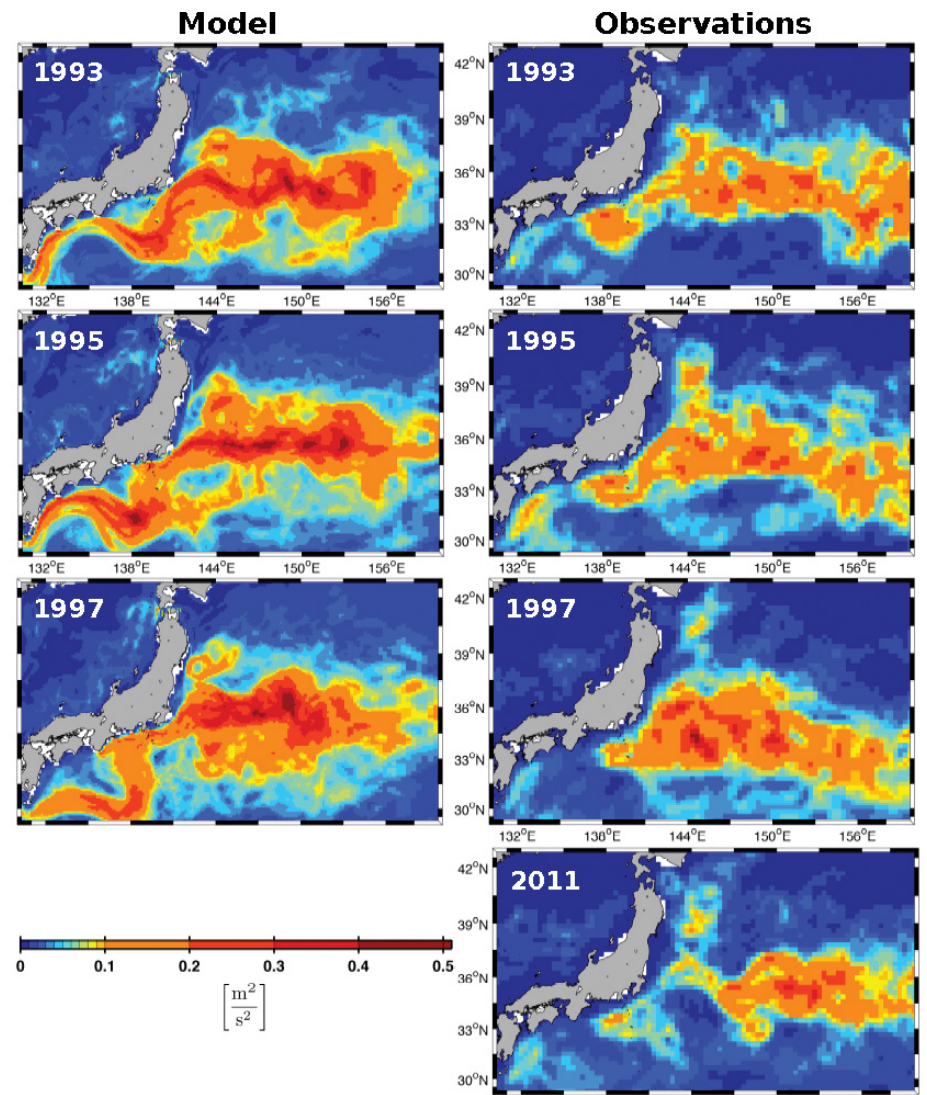
Fig. 4. Eddy kinetic energy as defined by Eq. (1). The left row of panels refers to simulated nominal years indicated in the respective upper left corners. The right row refers to estimates based on geostrophic velocity anomalies as observed from space. Due to lagged data access, the 2011 observations refer to an average from September 2010 to September